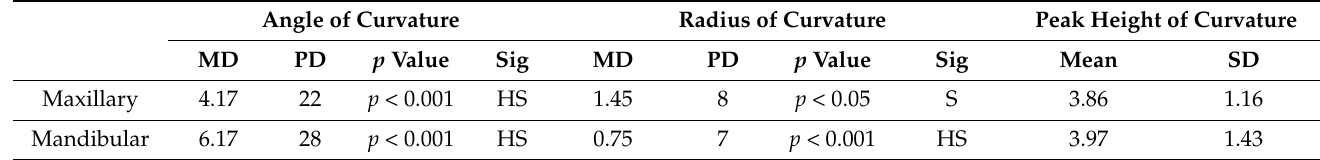
Table 2. The average difference in values between Jig method and Schneiders